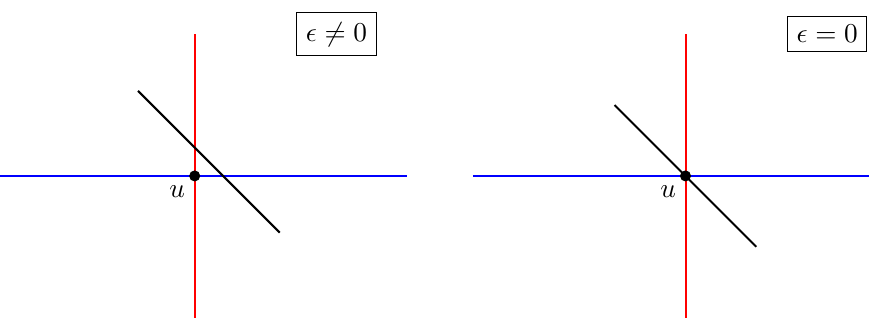
Figure 2 . The gauge 7-branes are on top of each other and denoted by the blue line. The residual discriminant locus is denoted by the red line, which for the moment we assume to be normal crossing. The black line segment denotes a disk that intersects the 7-branes. In the left figure the disc misses the codimension-two point u , but intersects the codimension-one loci each at a point. In the right figure the disc has been deformed to intersect u at a